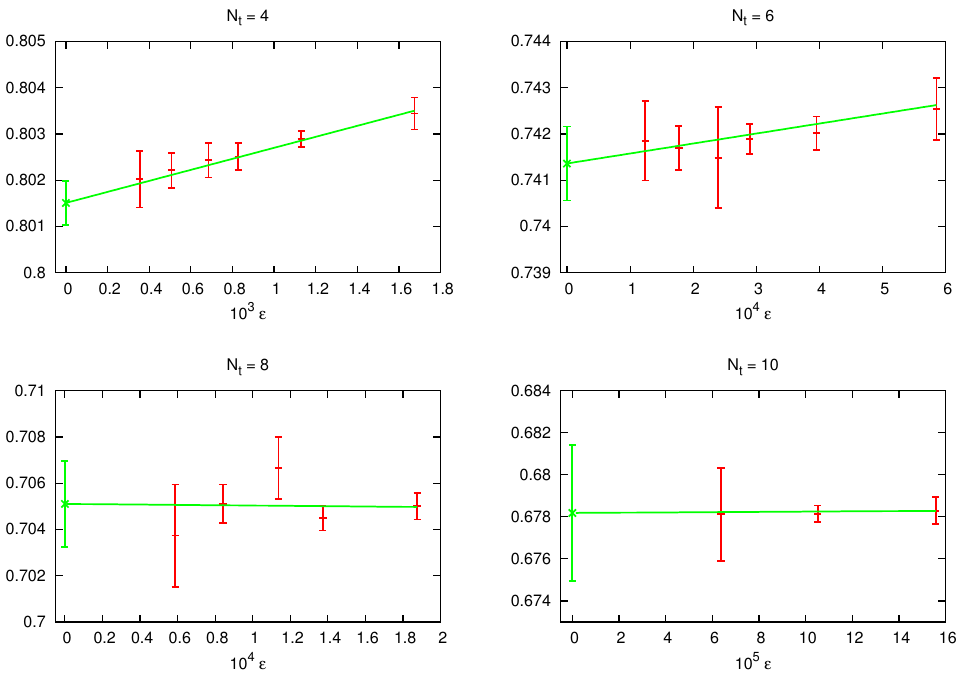
Figure 3 . In(cid:12)nite volume extrapolations of the critical couplings with the topological action; see equation (4.4).